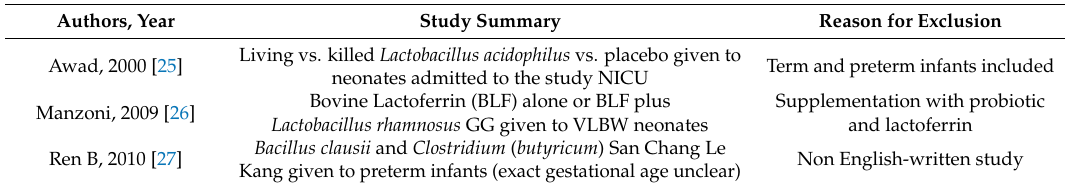
Table 2. Studies excluded from the systematic review.